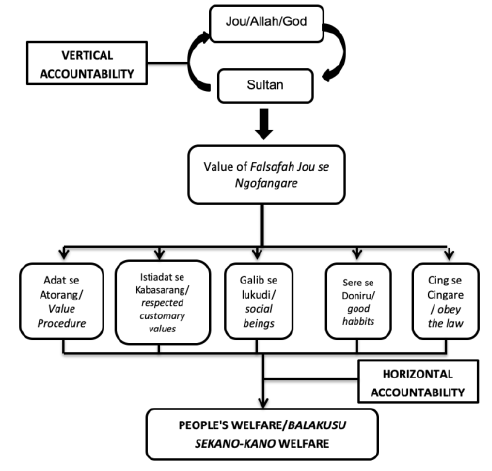
Figure 1: Results of field data